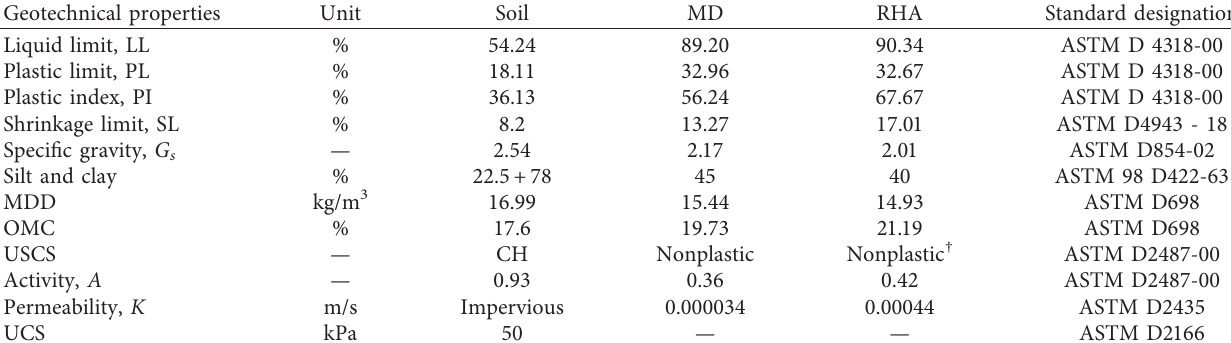
Table 1: Index properties and geotechnical characteristics of soil, marble dust, and rice husk ash.